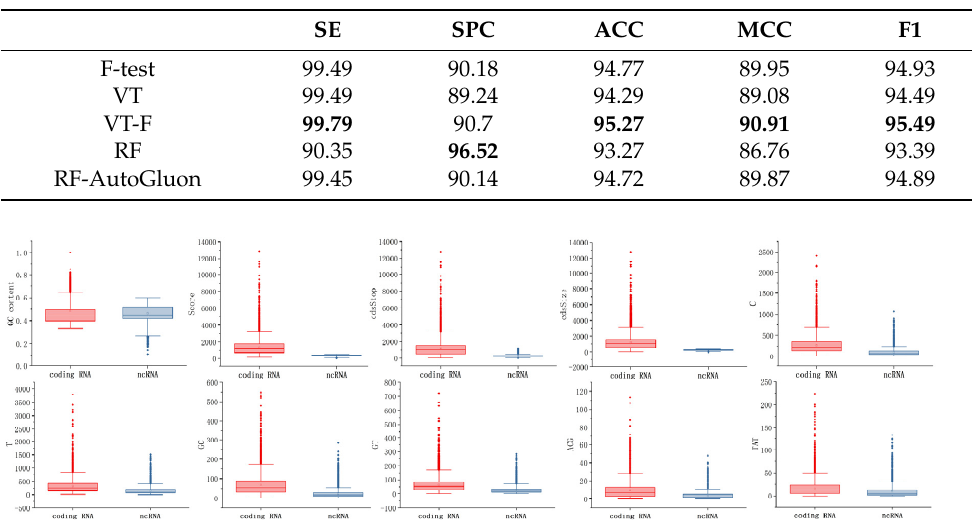
Table 1. Comparing the performance of different feature selection methods.